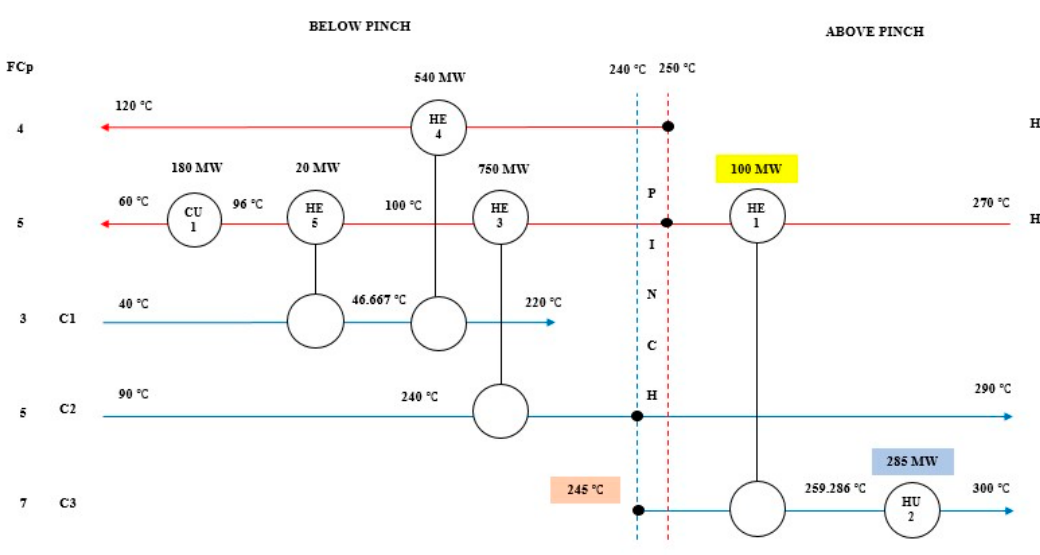
Figure 11. HEN design with increasing T S for the hot stream H1 above the pinch.